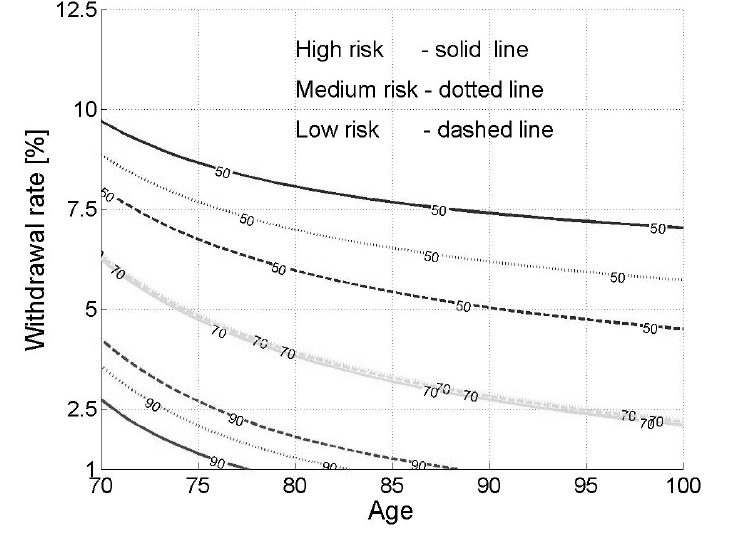
FIGURE 4: Survival probabilities as a function of time and withdrawal rate Source: